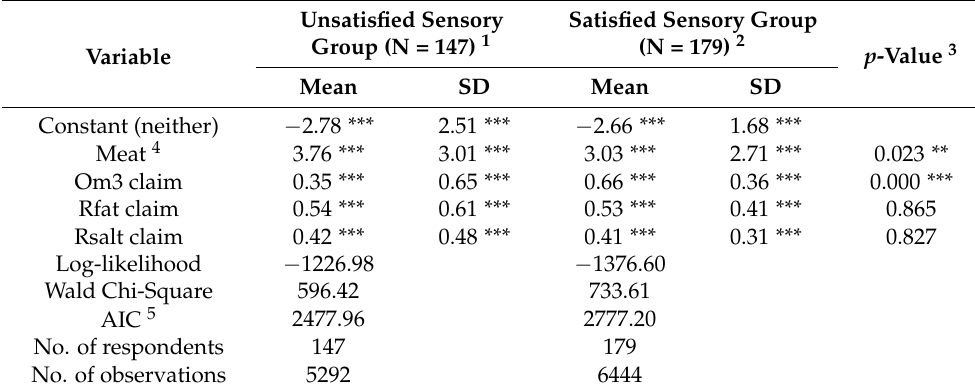
Table 4. WTP estimation by the satisfactory and unsatisfactory groups.